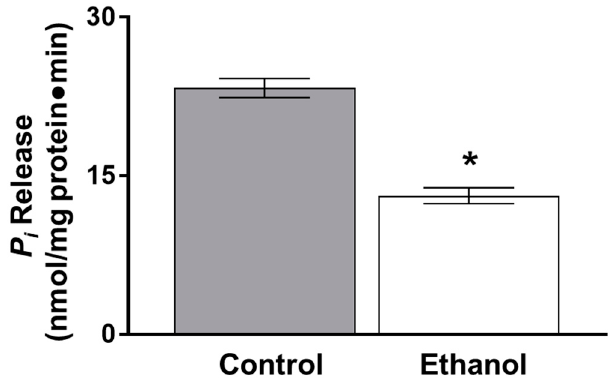
Figure 2. Moderate ethanol significantly inhibited Na-K-ATPase activity in Sprague Dawley (SD) rats. Na-K-ATPase activity was measured as a function of inorganic phosphate (P i ) release following one hour of ethanol exposure (* p < 0.01, n = 4). The error bars represent the SEM.